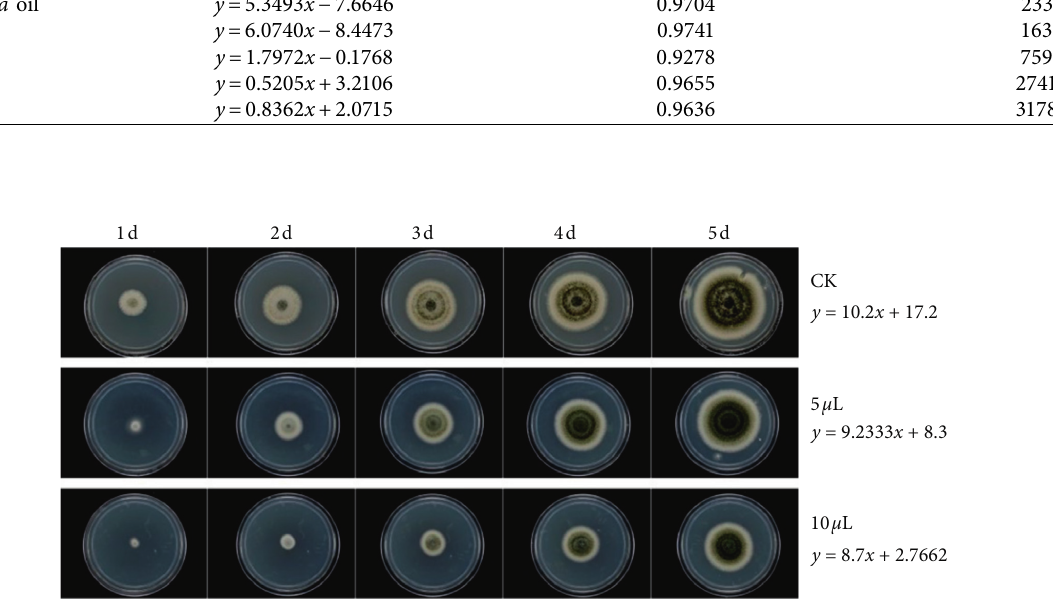
Figure 2: Effects of citral on colony growth of A. flavus